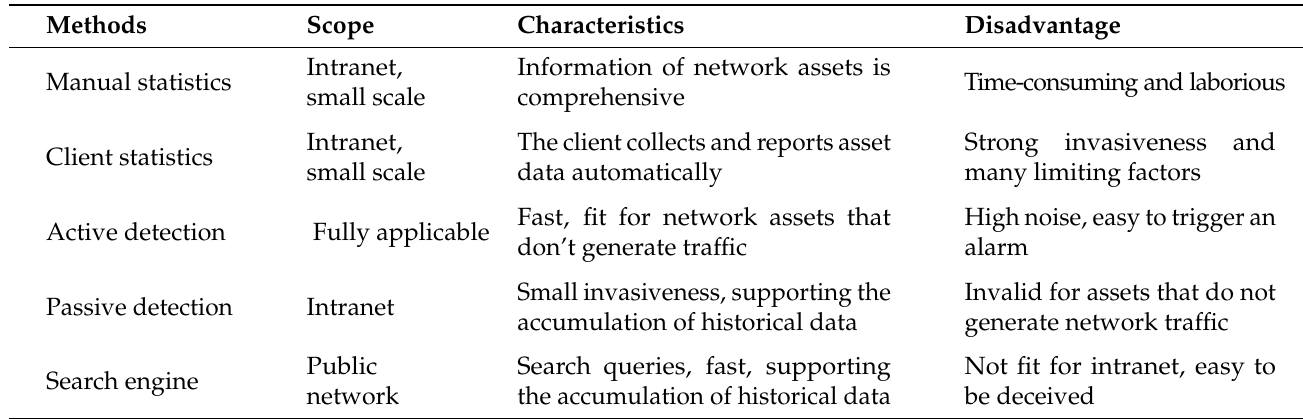
Table 2. Comparison of network asset detection